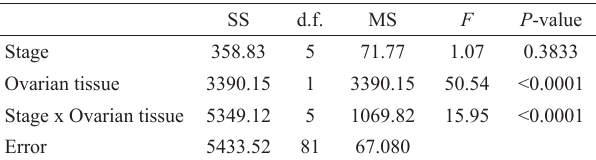
Table 3. Results of the ANCOVA that evaluated the relationship between the weight of the batches (n = 93) and their respective ovarian tissue across stages of embryonic development of the one-sided multidentata .